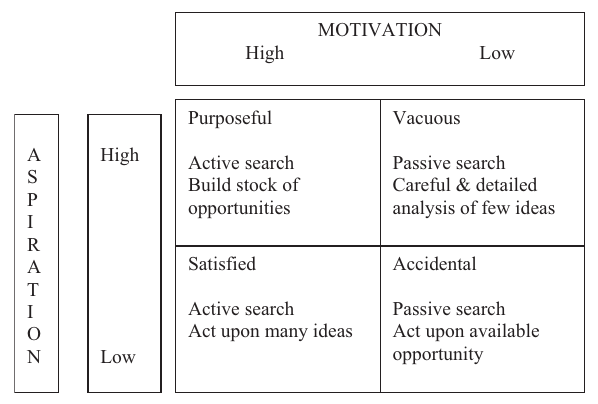
FIGURE 3 | Aspiration and motivation with entrepreneurial